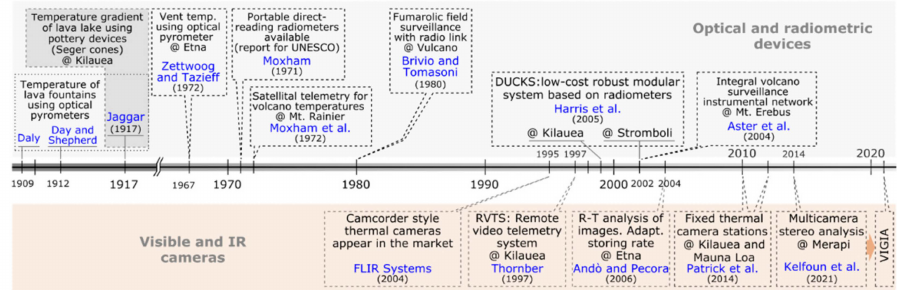
Figure 2. A brief (non-exhaustive) chronology of the evolution of permanently installed instrumen- tation for measuring temperature at volcanoes. Each milestone is defined by a scientific publica- tion [25,34–36,38,39,41–44,46–48]; the author is indicated in blue letters and the year of publication in parentheses. The pins show the installation time, some of the above systems remain operational at the time of writing